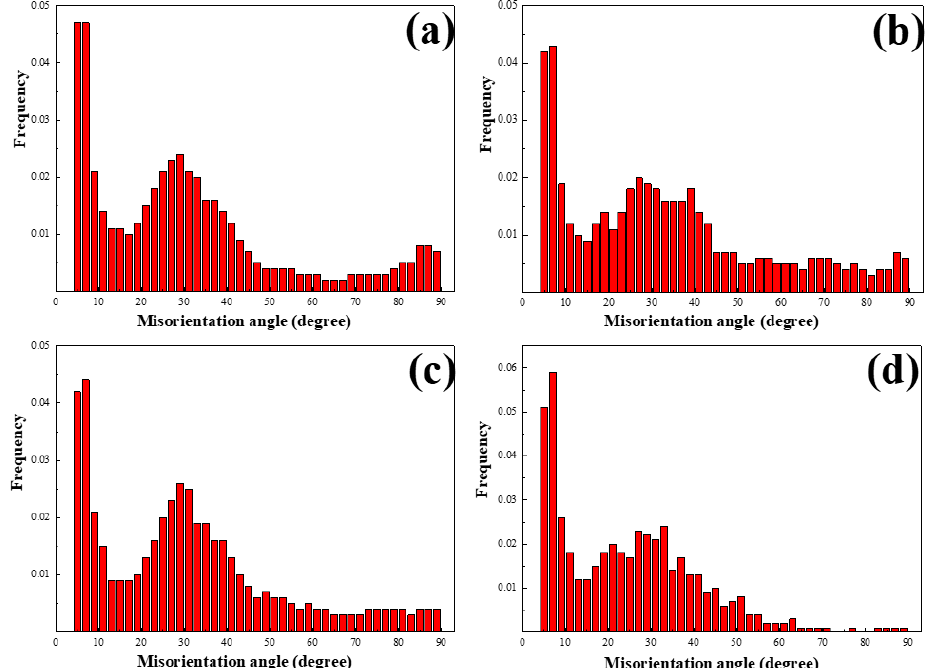
Figure 5. Misorientation angles of the grains of the rolled AZ80 magnesium alloy pre-aged for: ( a ) 75; ( b ) 160; ( c ) 200 and ( d ) 240 min.